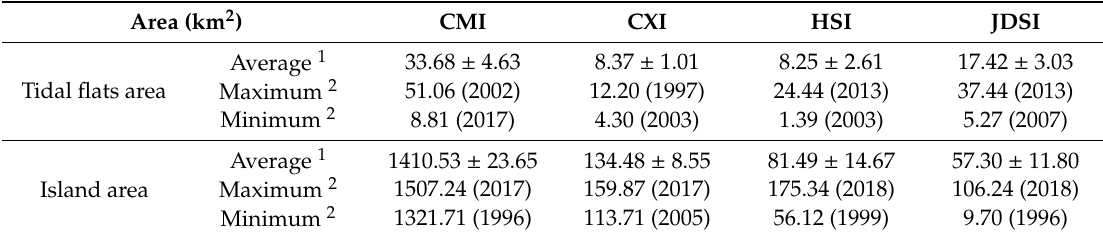
Figure 7. Reclamation, tidal flats, and island areas in ( a ) CMI, ( b ) CXI, ( c ) HSI, and ( d ) JDSI from 1996 to 2018. Reclamation and tidal flats use the primary y-axis on the left, and islands use the secondary y-axis on the right. Table 3. Statistical summary of tidal flats and island areas in YRE from 1996 to